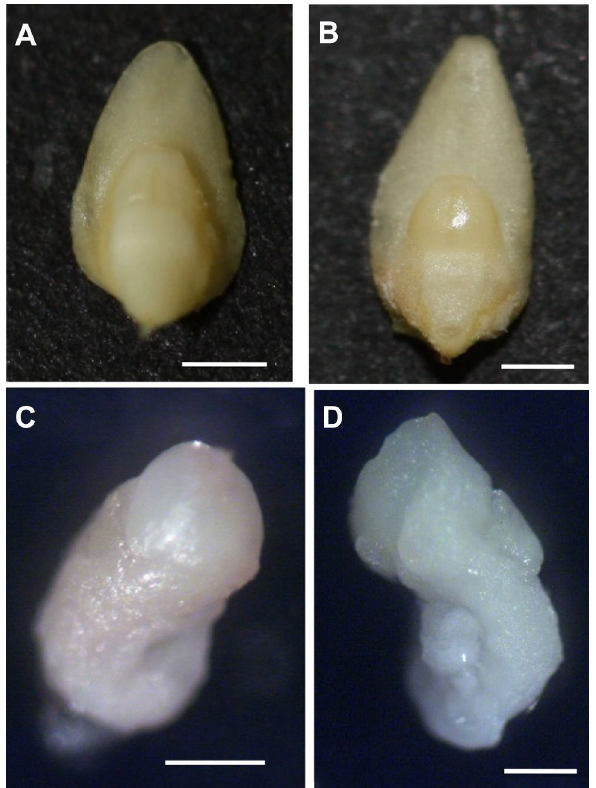
Figure 1. Morphology of oat embryos. ( A ) zygotic embryo cv. ‘Krezus’, ( B ) zygotic embryo cv. ‘Akt’, ( C ) haploid embryo cv. ‘Krezus’, ( D ) haploid embryo cv. ‘Akt’. Scale: ( A , B ) 1000 µm, ( C , D ) 500